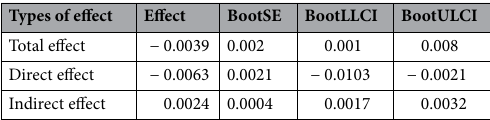
Table 7. Bootstrap results of the mediating effect.